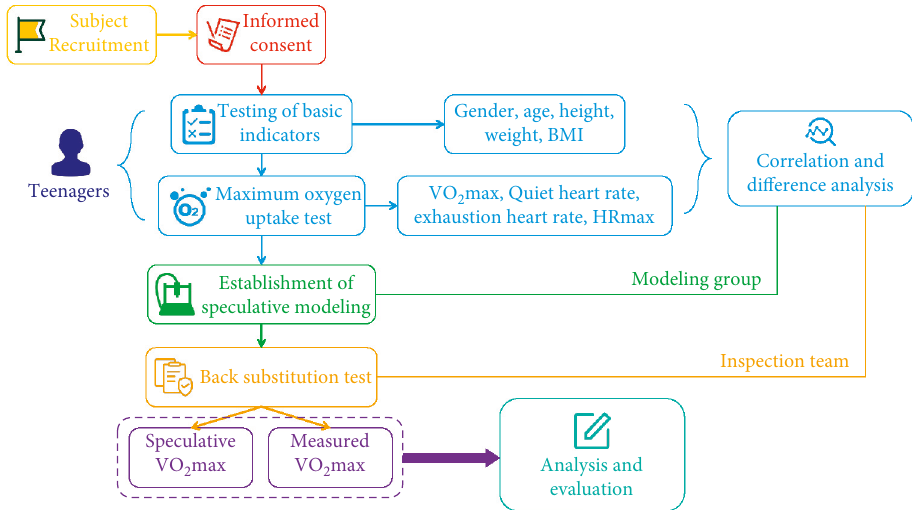
Figure 1: Construction process of identification regression